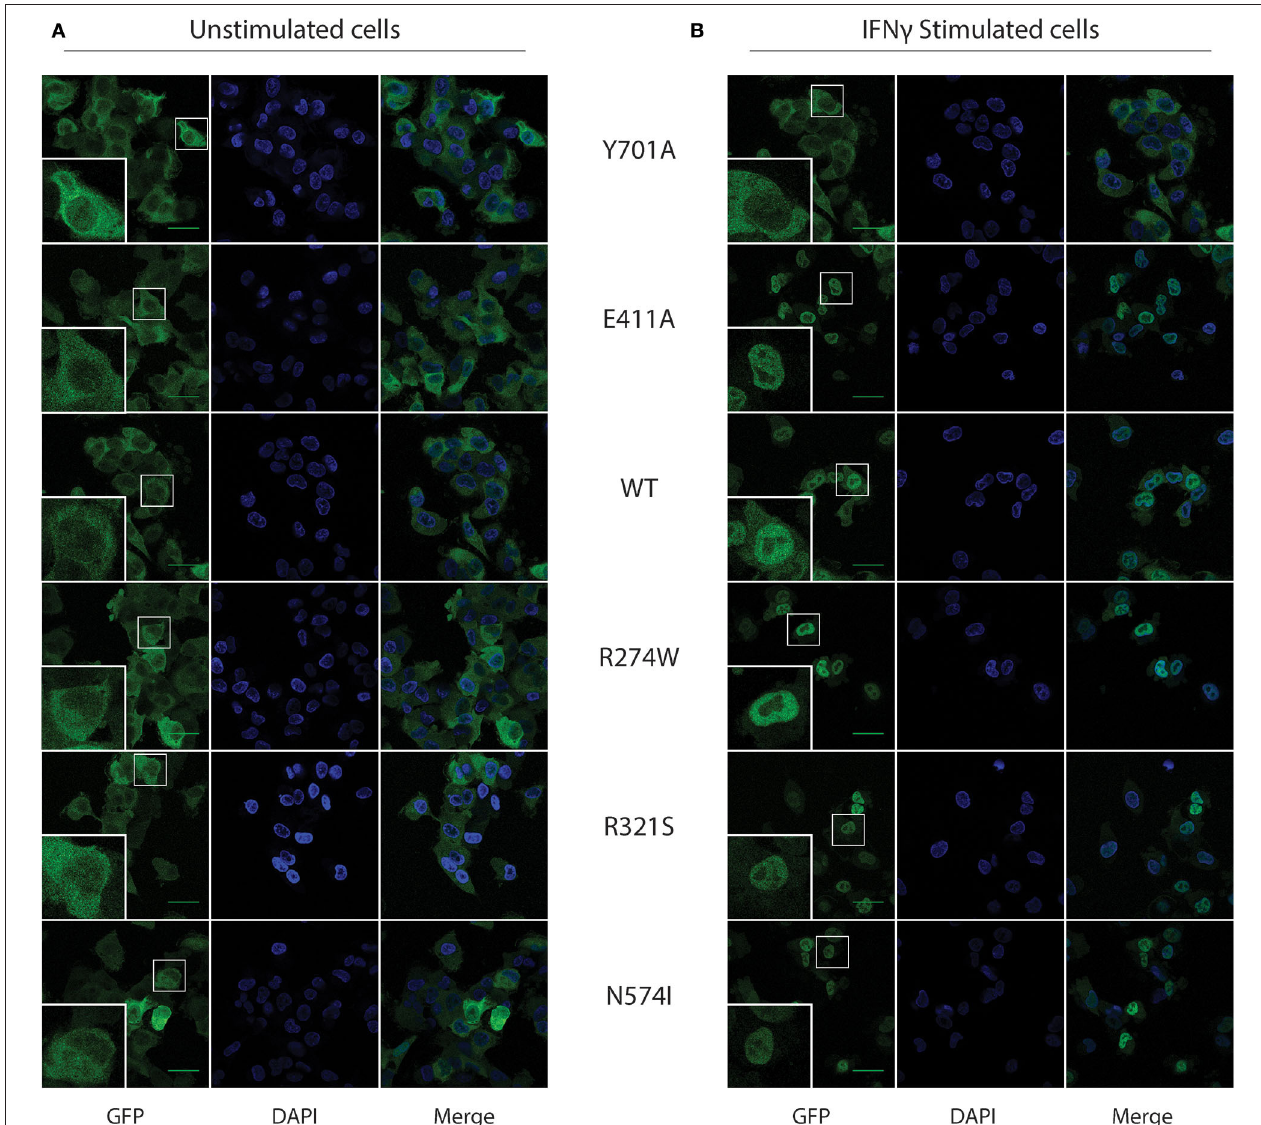
FIGURE 2 | STAT1-GFP subcellular localization in U3A cells before and after IFN γ stimulus. (A) Confocal images for the respective STAT1 GFP expressing, unstimulated, U3A cells. (B) U3A cells after 1h of IFN γ (1 U/ µ l) stimulation. Green scale bar is 40 µ m. Bottom left inset in each image shows a zoom-in of the cell in the smaller white